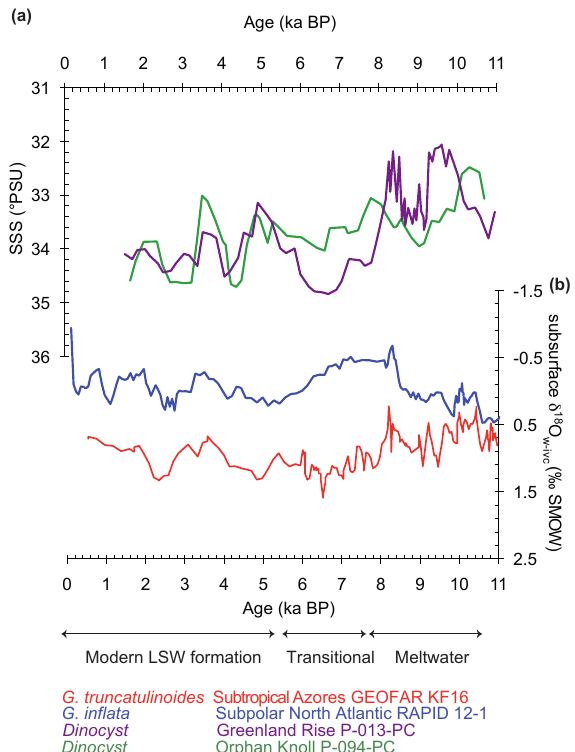
Figure 4. Comparison between (a) SSS reconstructions (summer season salinity estimates) based on dinoflagellate cyst assemblages from the northern and southern entrances of the Labrador Sea (Solignac et al., 2004) and (b) subsurface salinity reconstructions from subtropical (red) to subpolar (blue) North Atlantic δ 18 O w-ivc records (Thornalley et al.,